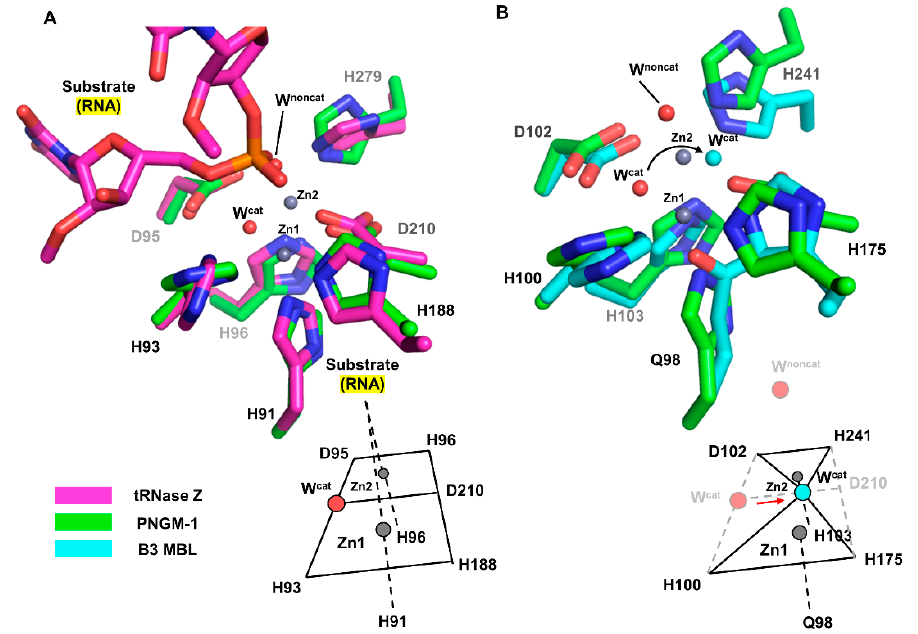
Figure 3. Comparison of the MBSs between PNGM-1 and Bs-tRNase Z and B3 MBL GOB-18. ( A ) The MBS of PNGM-1 (green) superimposed on that of Bs-tRNase Z (magenta). The metal ions (grey spheres) and water molecules (red spheres) belong to the structure of wild-type PNGM-1. ( B ) The MBS of PNGM-1 (green) superimposed on that of B3 MBL GOB-18 (cyan). The metal ions (grey spheres) and red water molecules belong to the structure of wild-type PNGM-1, whereas the cyan water molecule belongs to that of GOB-18. Metal coordination schemes are shown at the bottom.